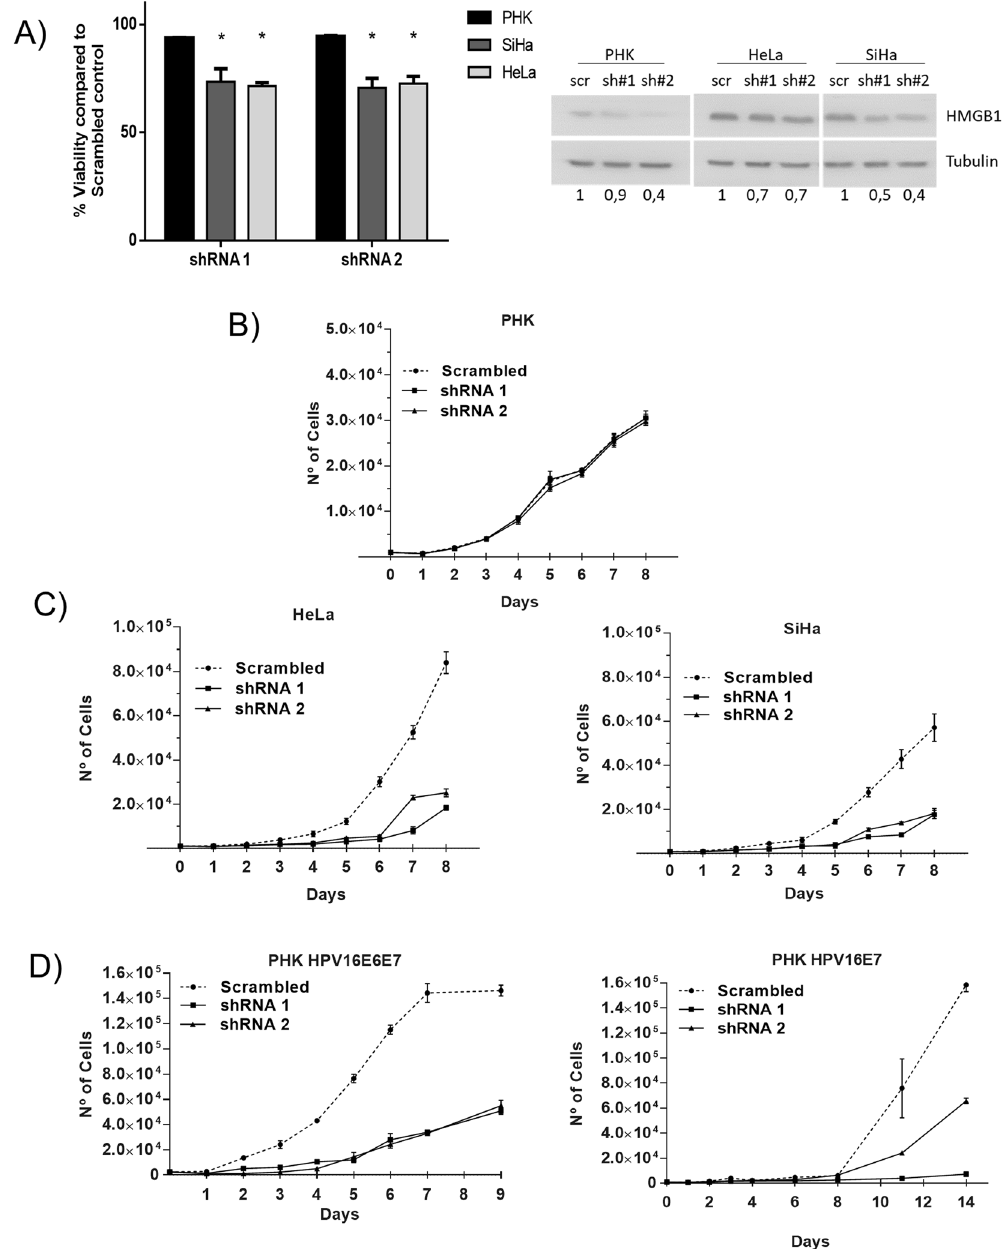
Figure 4. HMGB1 silencing selectively inhibits cell viability and proliferation of SiHa and HeLa cell lines. ( A ) Viability of silenced cell lines was determined by AlamarBlue reduction. Cells were seeded in 96-well plates (2000 cells/well) and infected with lentiviral particles expressing specific shRNAs. After five days, AlamarBlue was added (10 µ l/well) and reagent reduction was determined by absorbance measurement after four hours. Viability inhibition values for each cell line are reported as relative to those observed in cells transduced with a scrambled shRNA. ( B , C ) HMGB1 silencing has no effect on normal keratinocytes proliferation ( B ), but inhibits SiHa and HeLa growth ( C ), as well as, PHK expressing HPV16 E6E7 or only E7 ( D ), as determined by proliferation curves. Cells previously transduced with lentivirus vectors for silencing HMGB1 were seeded (1000 cells/well in 24-well plates) and the number of cells was counted in triplicate for eight days. (Student’s t test, p ≤